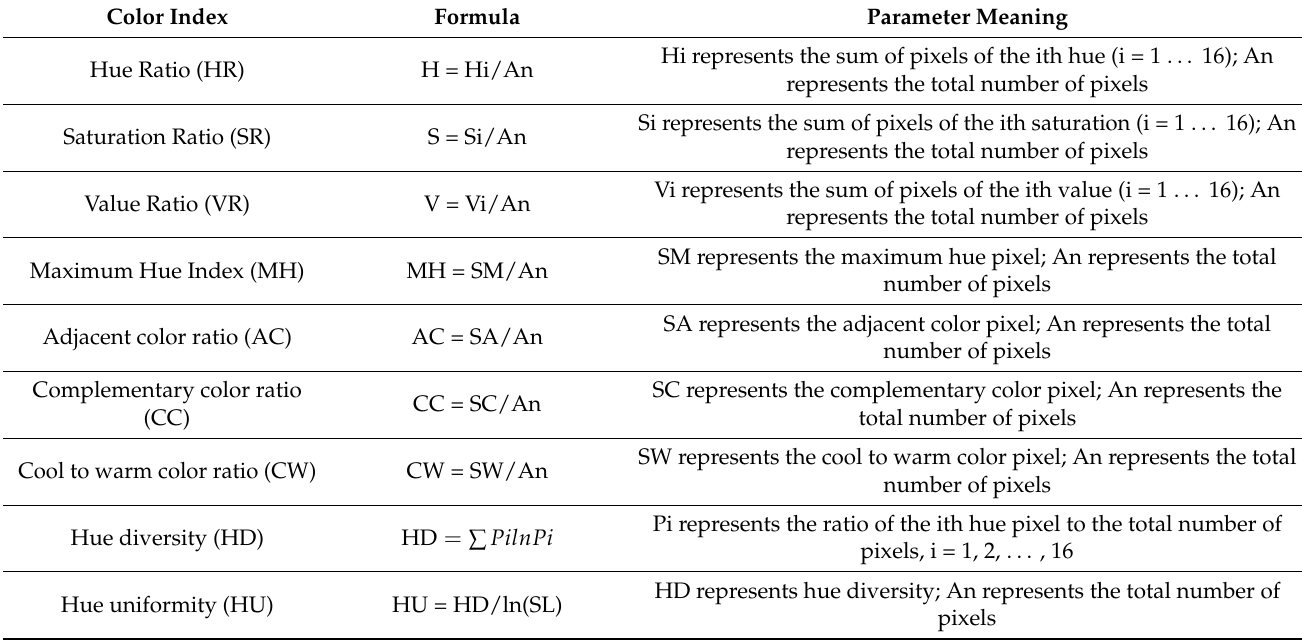
Table 2. Quantification of color